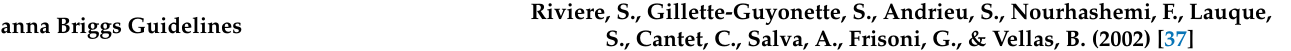
Table 3. Joanna Briggs Institute risk of bias ratings for the cohort study